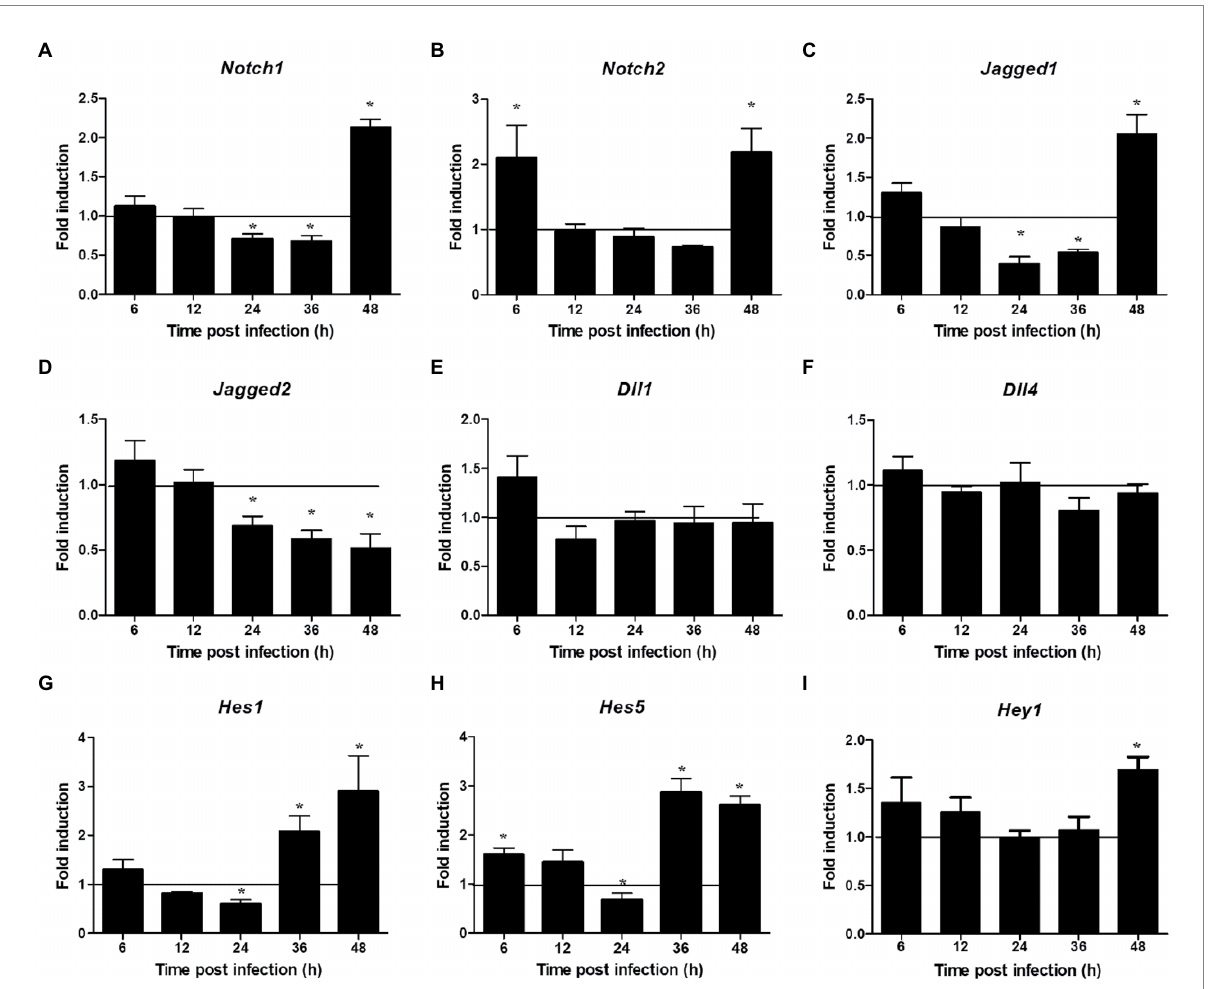
FIGURE 3 Expression profile of Notch molecules in LMH during FAdV-4 infections at 6–48 hpi. (A) Notch 1 , (B) notch 2 , (C) jagged 1 , (D) jagged 2 , (E) dll 1 , (F) dll 4 , (G) has 1 , (H) has 5 , (I) hey 1 . Relative expression is normalized to β -actin . The y-axis represents the fold change in target gene expression in LMH compared with that of the control and the above line ( y = 1) on the x -axis represents the control. Data are shown as mean [standard deviation (SD)] with n = 3 per group. * p <